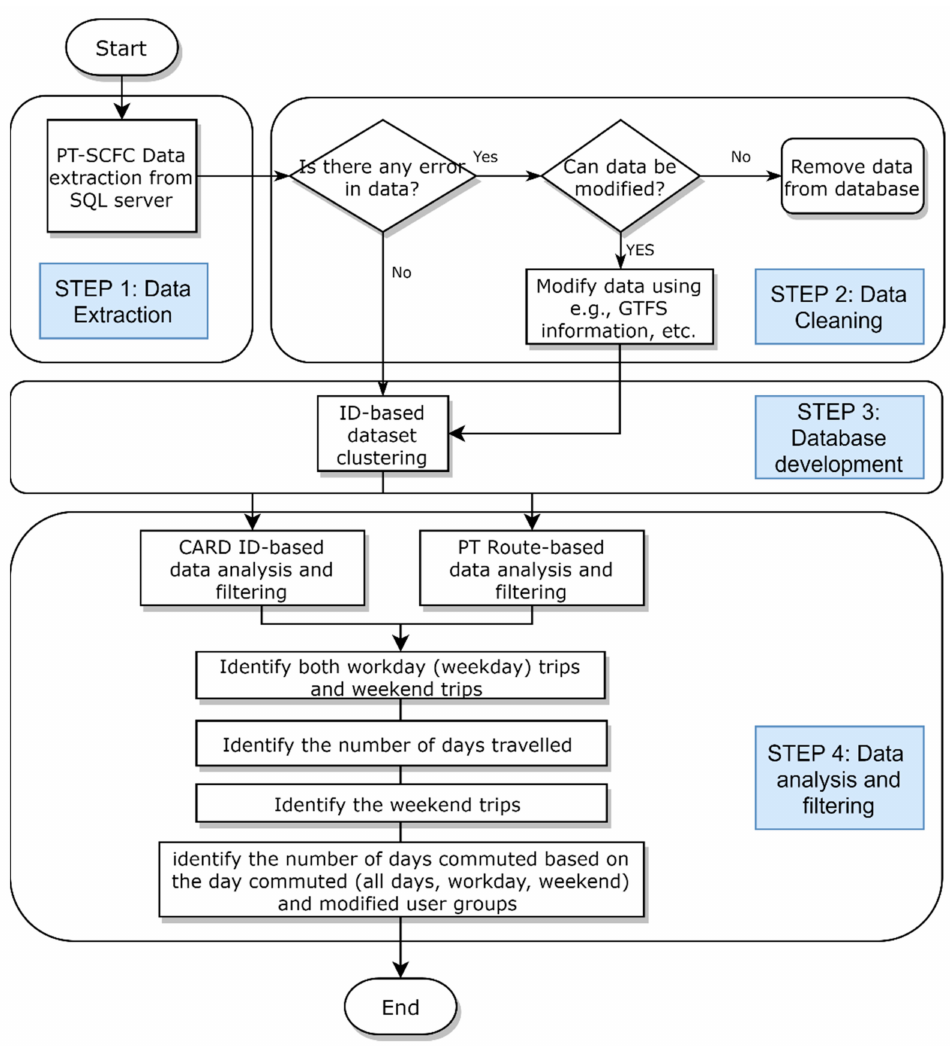
Figure 2. Flow chart of the data mining and categorization in this study. To apply group characterization, first the whole data set (1 month) is considered as an ensemble data set. Then, the raw datasets were subdivided into large, homogeneous clusters on the basis of trip patterns observed over a monthly basis. The goal was to split users in homogeneous groups according to their behavior and illustrate the similarity between each group. Afterward, card holders were categorized according to the number of days they used PT. For this, the following equations were defined to examine the impact of user groups’ frequency and to detect this group of users in data